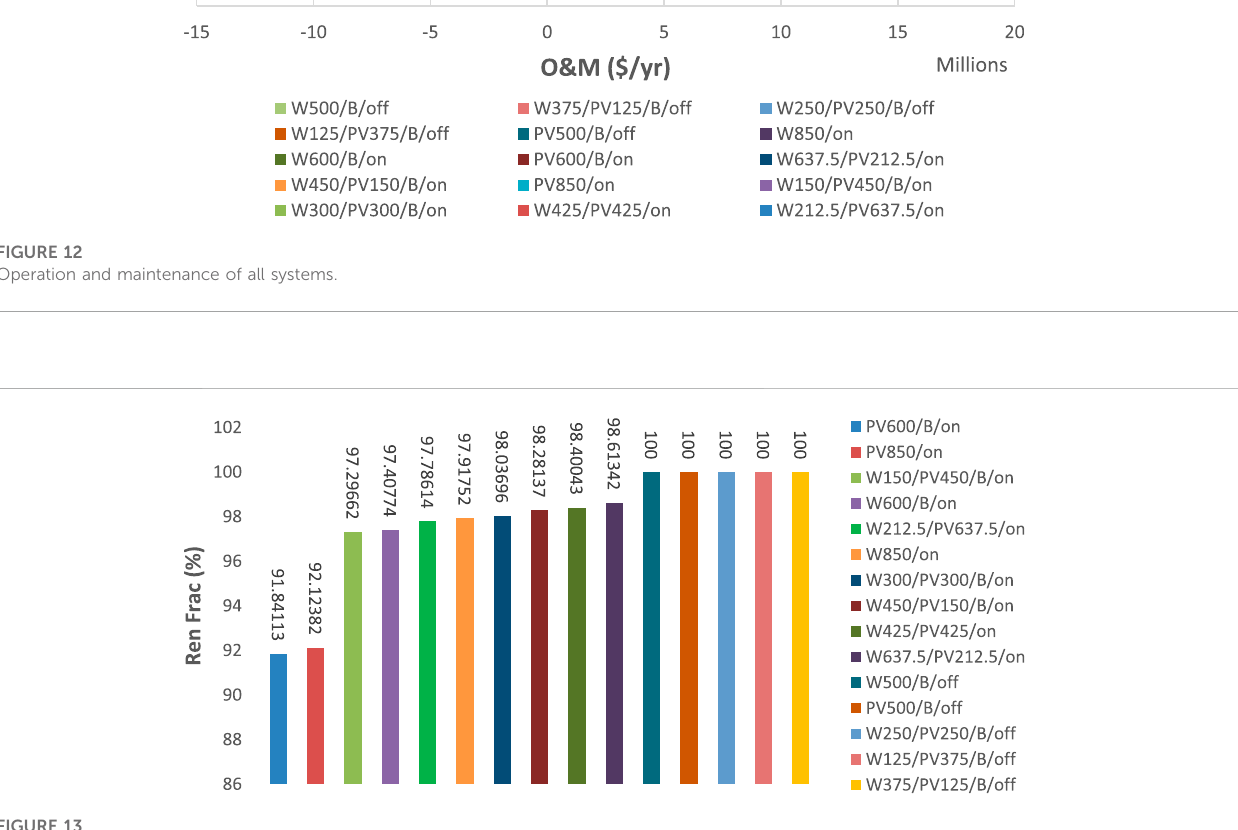
FIGURE 13 Renewable fraction of all